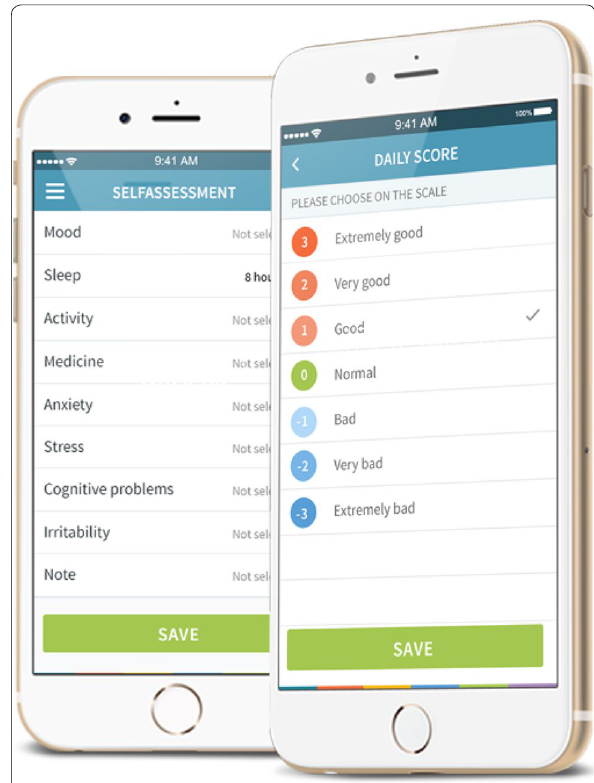
Fig. 2 Screenshots from the Trilogis‑Monsenso monitoring